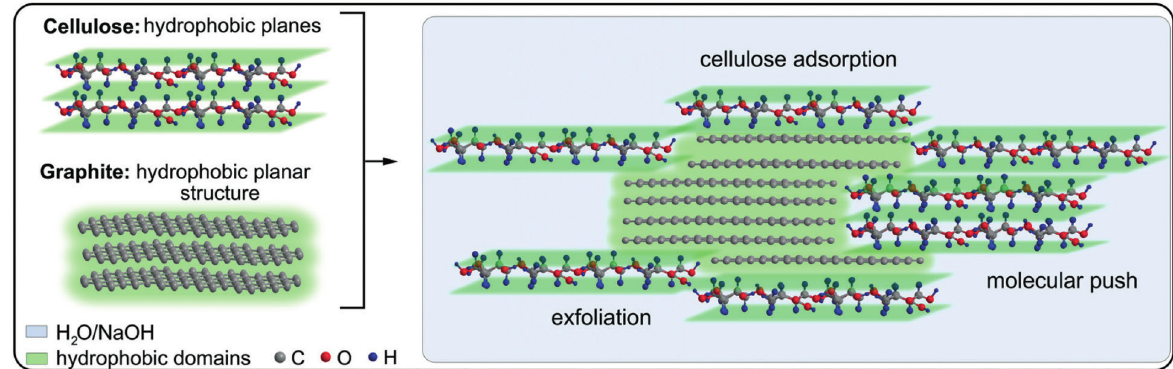
Figure 2 - left: Representation of cellulose and graphite structures. Right: Disassembly of graphene stacks due to cellulose adsorption that pushes single or multiple lamellae towards the aqueous solution. Cellulose aggregates may also participate in these events (not shown). Reproduced (adapted) from (Ferreira et al. 2017) with permission from The Royal Society of